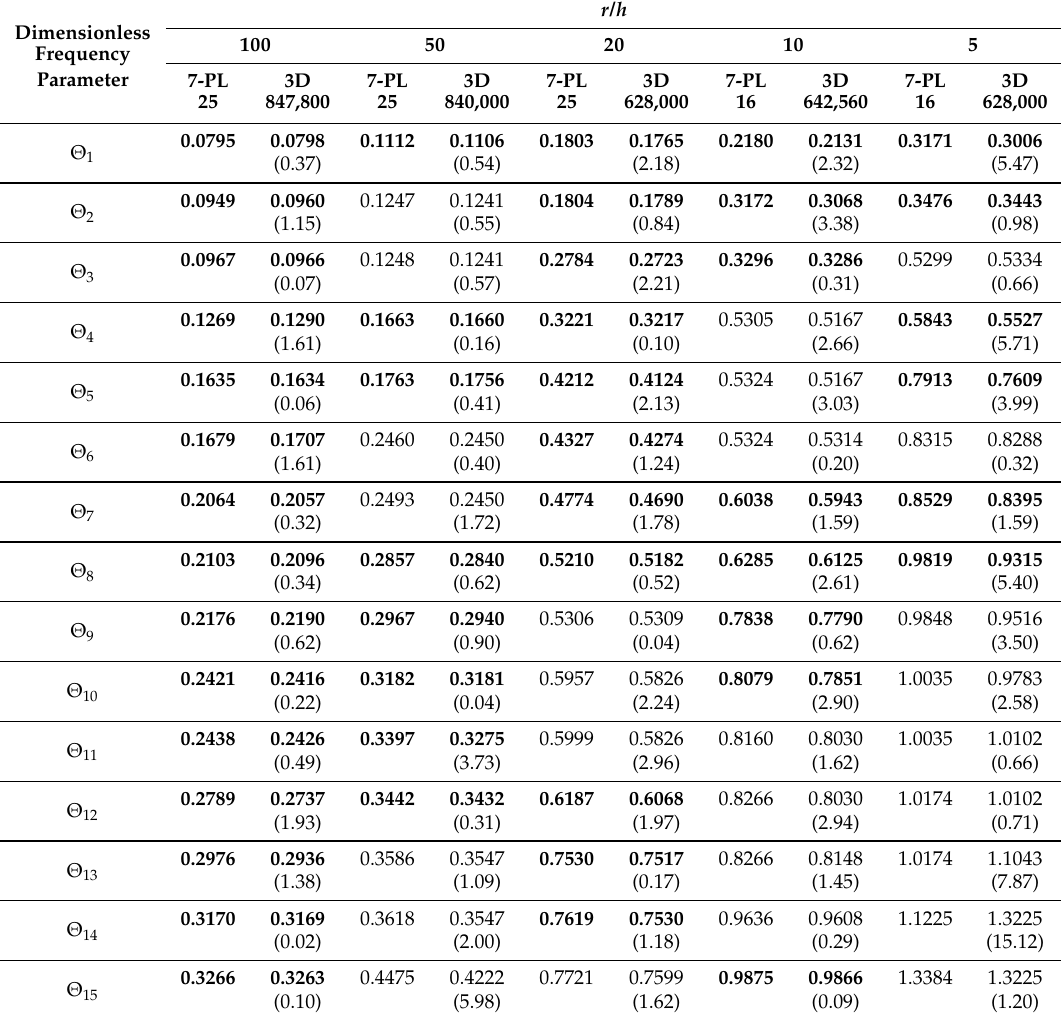
Table 19. Dimensionless natural frequencies parameter Θ for cylinders with linear thickness variation and CF boundary conditions, L / r =